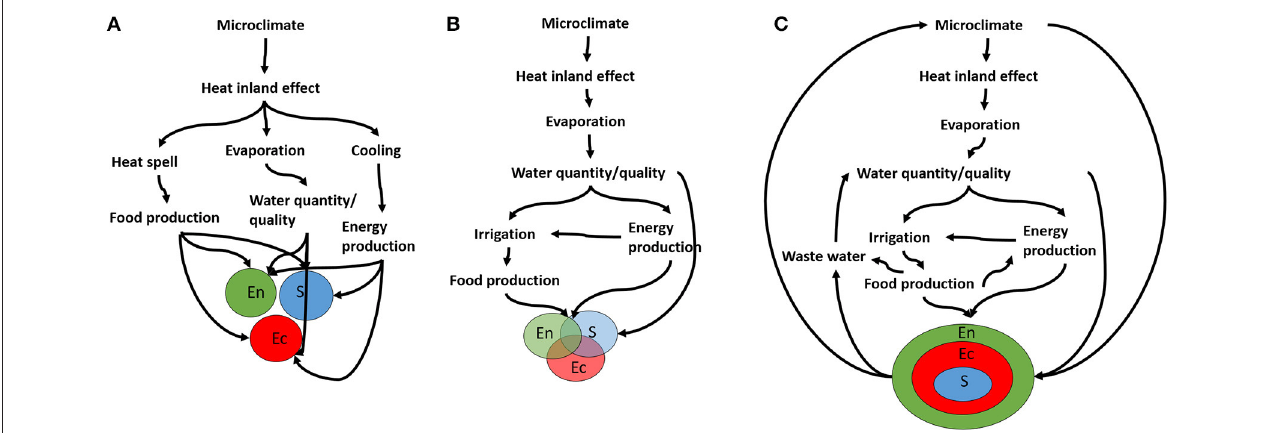
FIGURE 5 | Example causal loop shows the complexity in the columns as well as combining it with outside dimensions for the three scenarios. Examines three causal chain and loop scenarios. (A) The output is the microclimate temperature changes affect the food system and impact crop yield and food production; (B) The output is the integrated socio-ecological food-energy-water system; (C) The response from the FEWS affects the causal chains through feedback or causal loops. In the figure, acronyms En, S and Ec represent environment, society and economy, respectively.